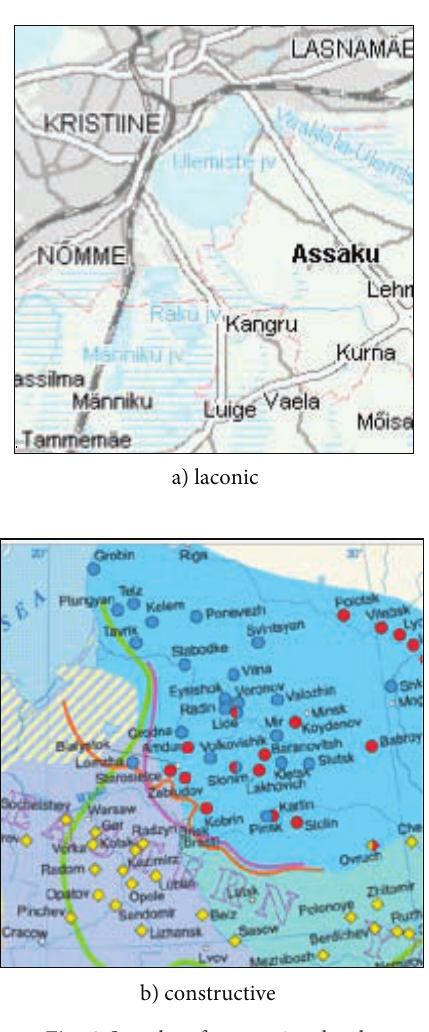
Fig. 6 . Samples of conventional